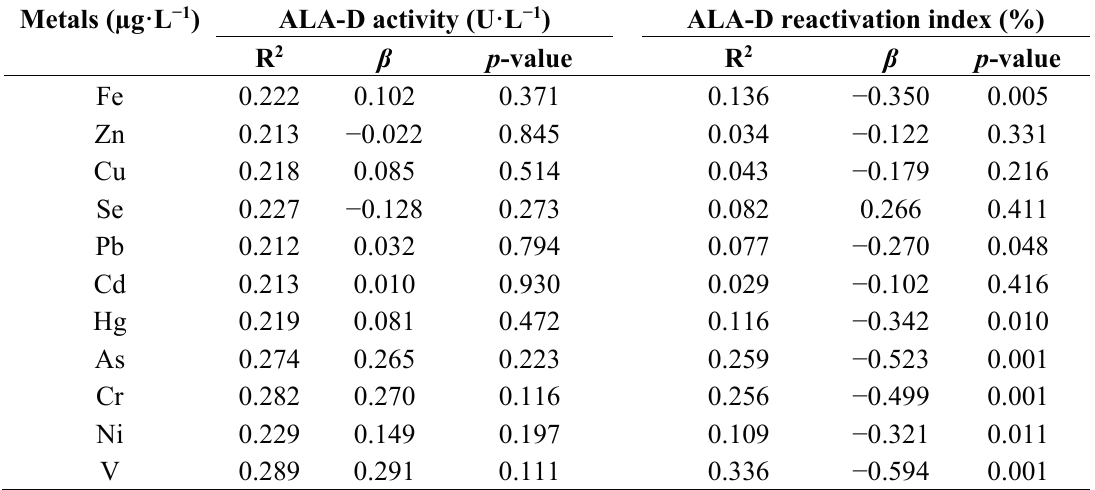
Table 5. Regression models between ALA-D activity and reactivation index versus metals ( n = 70).